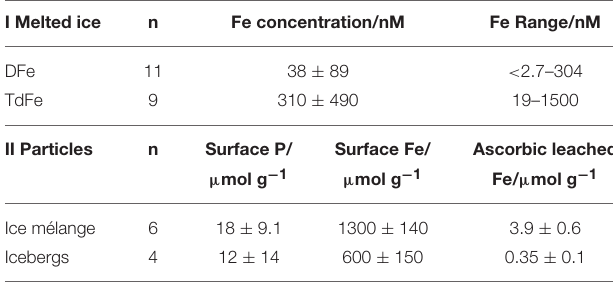
TABLE 1 | I Fe content of meltwater from